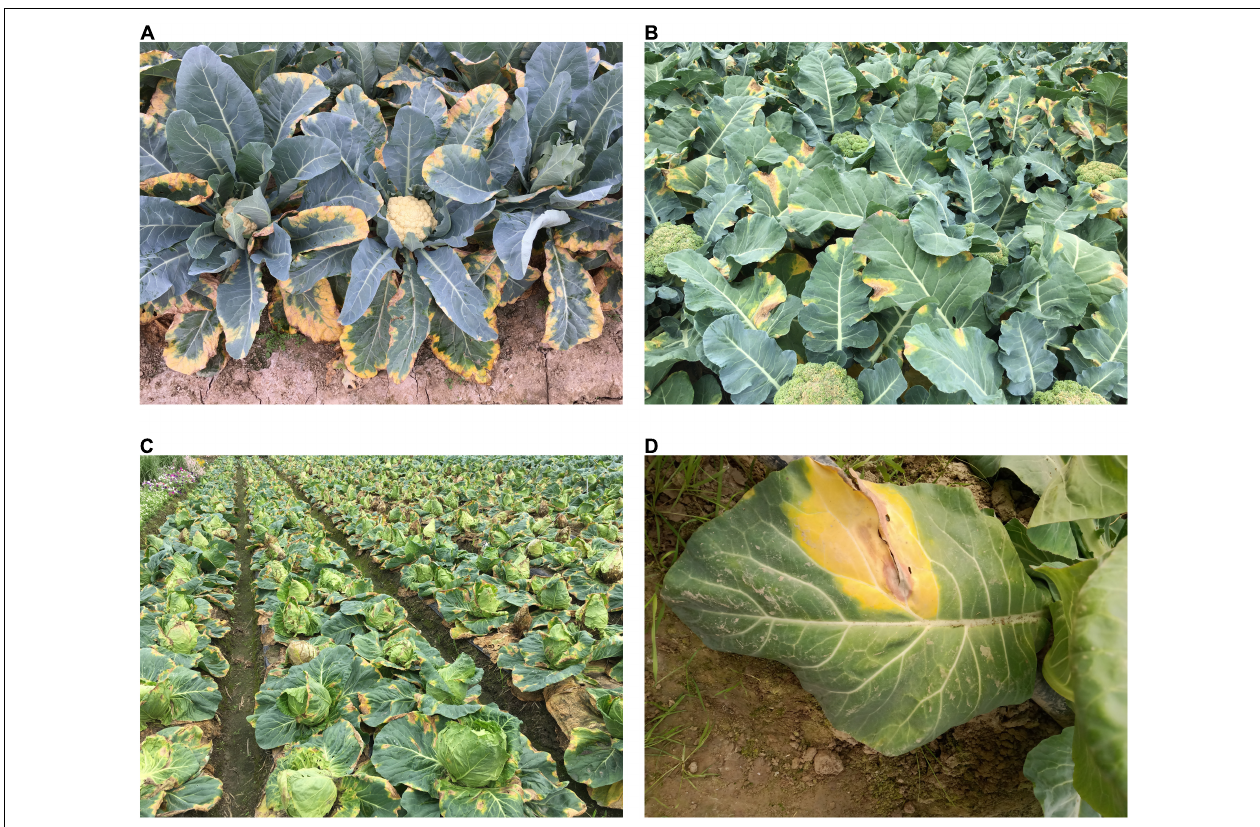
FIGURE 2 | Different Brassica oleracea varieties infested with Xanthomonas campestris pv. campestris [ (A) Cauliflower plants with severe Xcc infection, (B) Broccoli plants with typical symptoms of Xcc , (C) Cabbage plants with heavy Xcc infestation (D) Cauliflower leaves with characteristic V-shaped lesion caused by Xcc